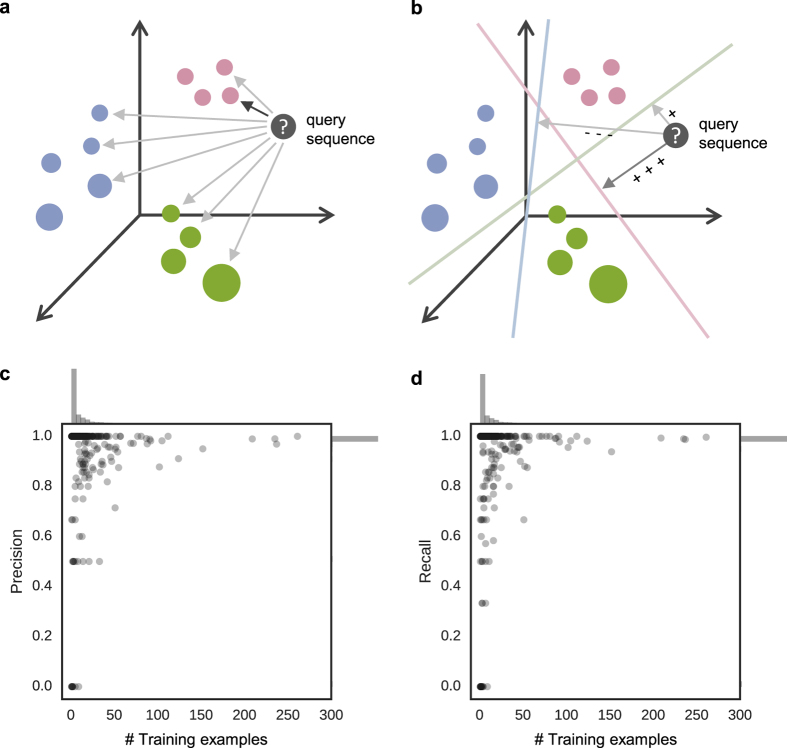
Classification and performance using the PESS.(a and b) Two different methods of classification using the PESS. Colored circles represent training examples within the PESS and are colored by fold. (a) In 1NN classification, the PESS distance between the query (gray circle) and all training examples is computed and the query is assigned to the fold of the nearest training example (dark gray arrow). (b) In 1-vs-all SVM classification, the PESS distance between the query and each of the fold-level hyperplanes (dotted lines) is computed, and the query is assigned to the fold that gives the best score (dark gray arrow), based on signed distance from the fold’s hyperplane. (c) Precision and (d) recall measures were computed for each fold separately after 1NN classification of the SCOP-25 set using the PESS and plotted against the number of training examples for each fold. Marginal histograms show the distribution of folds along each axis.